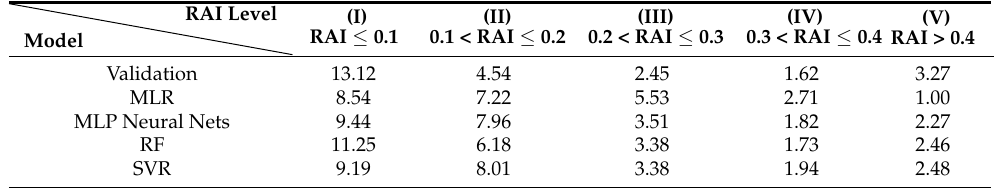
Table 1. The area of different RAI levels was calculated and compared.